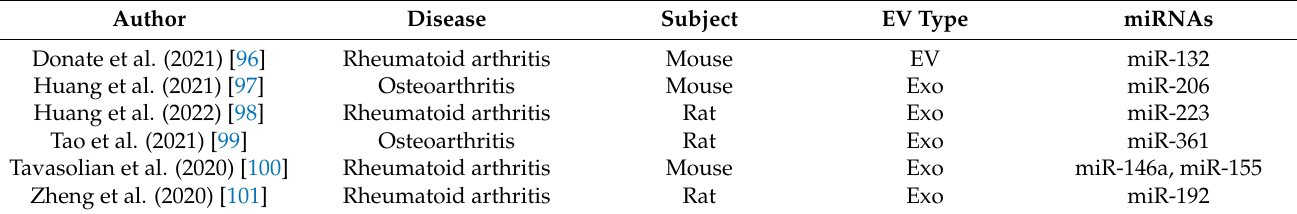
Table 6. Extracellular miRNAs in